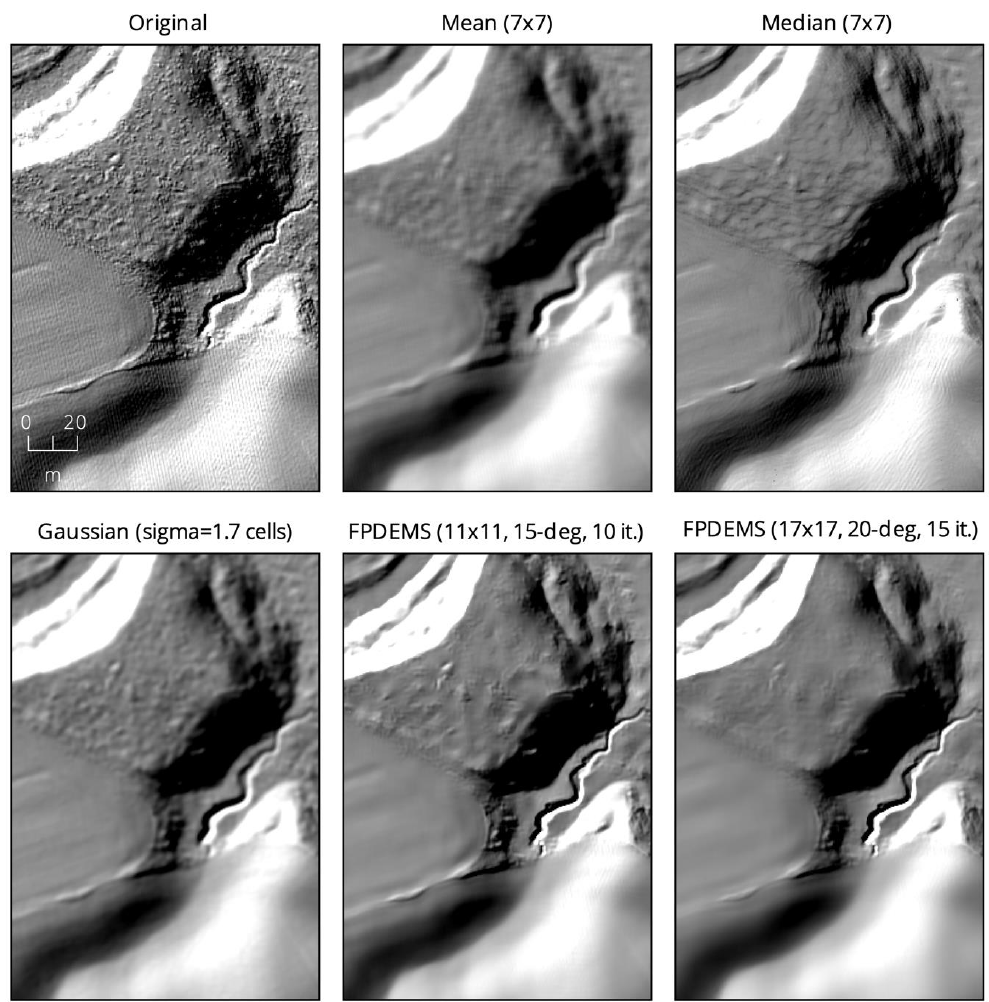
Figure 9. A comparison of the mean, median, and Gaussian low-pass filters and the FPDEMS method for smoothing fields, a gully, and a forested terrace hillslope within the study site DEM. Images present portions of the shaded relief images extracted from each DEM.